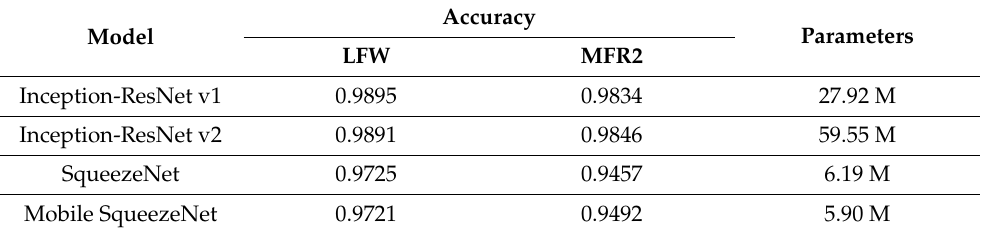
Table 5. Accuracy of different models trained on simulated VGGFACE2.